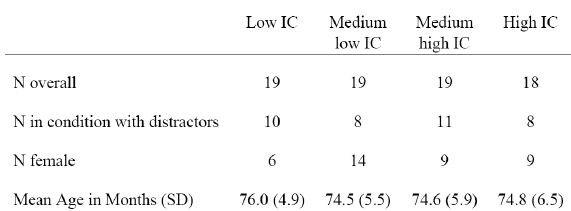
Demographic information as a function of group (based on performance in the interference control task (IC); quartiles)